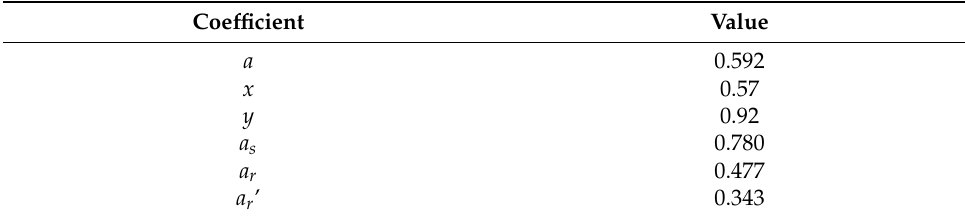
Table 2. Approximation coefficients for all three power loss models for the tested motor.